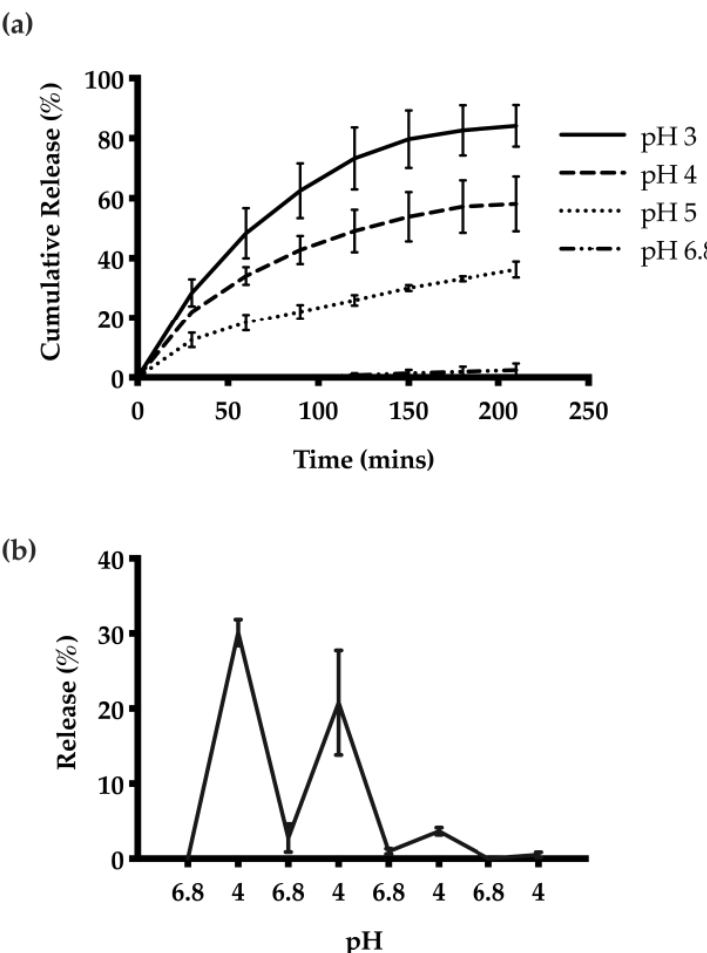
Figure 4. ( a ) Release of HTN3 from CNs at different pH values. The highest extent of release and most rapid release was observed at pH 3, and there was minimal release at pH 6.8. On average, at pH 3, the CNs were able to release 84% ± 7% of the encapsulated protein, 58% ± 9% at pH 4, 36% ± 3% at pH 5, and 2% ± 2% at pH 6.8. ( b ) pH cycling release results show that the CNs can adapt to environmental pH changes and can release protein selectively at pH 4 over 3 pH